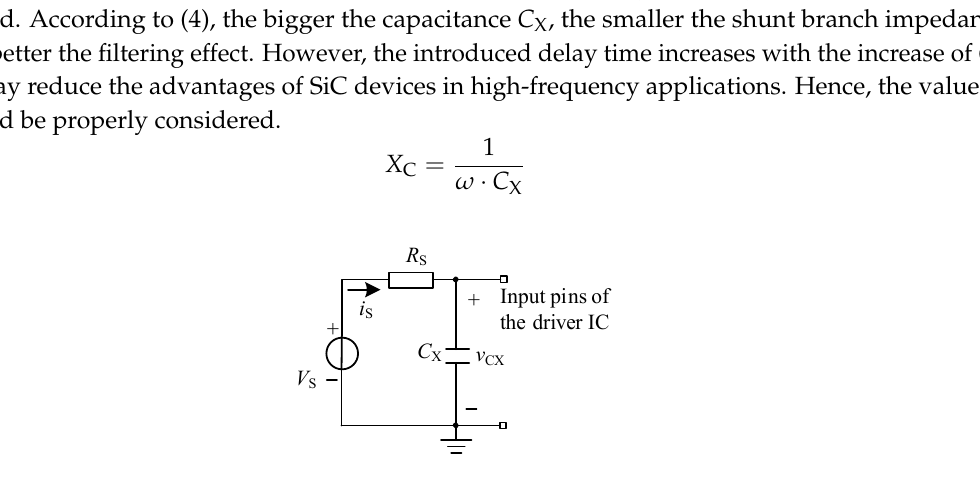
Figure 6. C X paralleled at the signal input port of the driver IC.